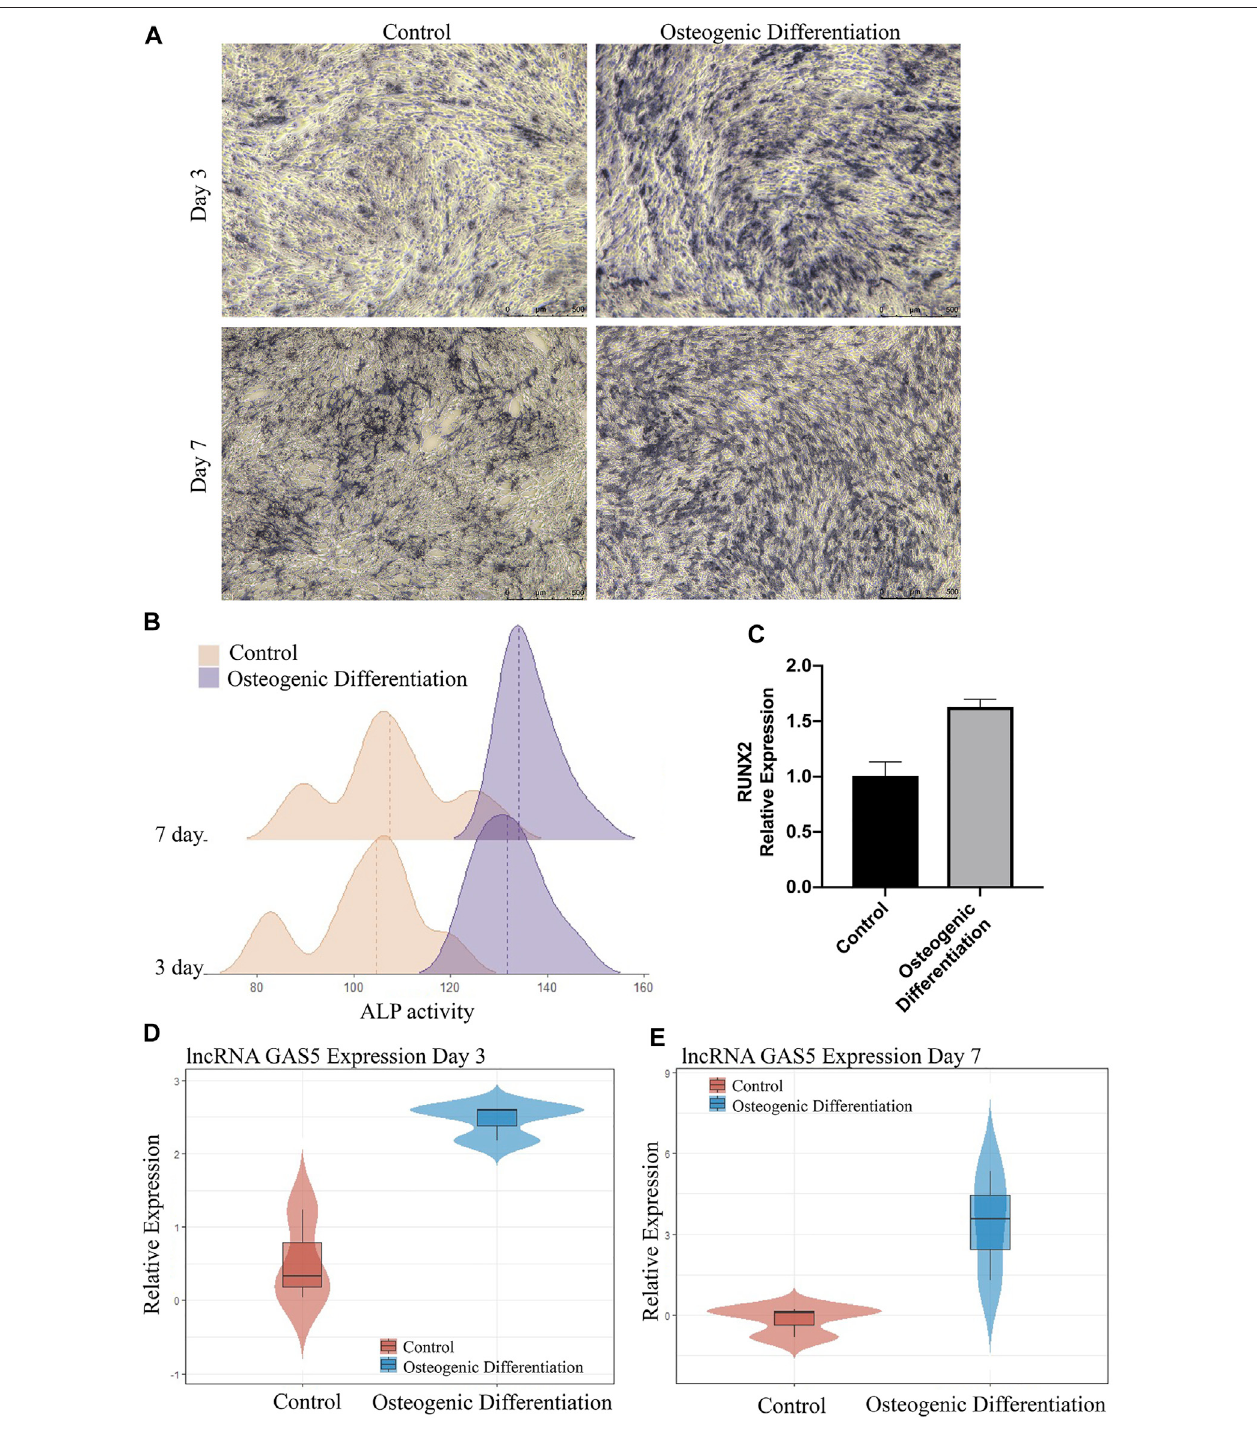
FIGURE 3 | Association between lncRNA GAS5 and BMSC osteogenic differentiation. (A) ALP staining on days 3 and 7 of osteogenic differentiation induction group andcontrolgroup. (B) RidgeplotforALPactivity. (C) RUNX2 expression levels onday7oftheosteogenicdifferentiationinduction groupandcontrolgroup. (D,E) lncRNA GAS5 expression level on days 3 and 7 after BMSC osteogenic differentiation induction (or control culture).